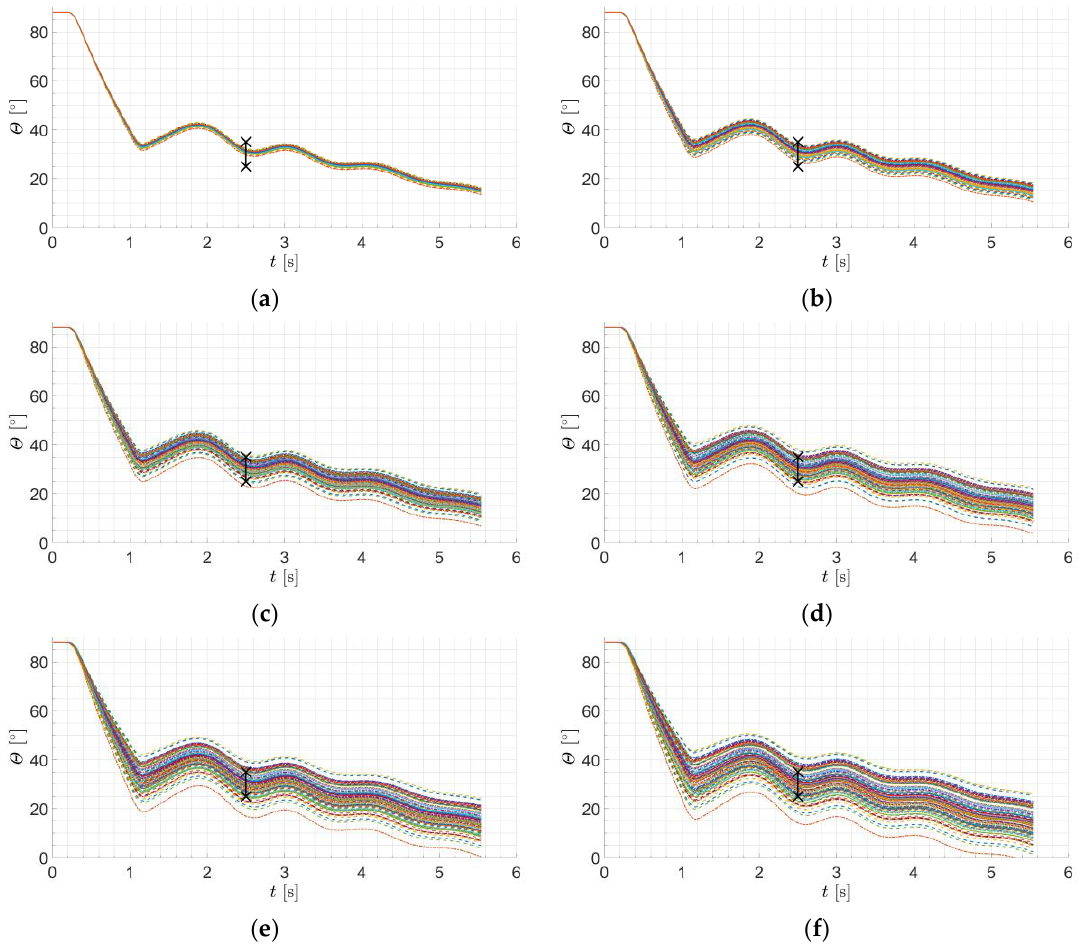
Figure 17. Projectile pitch angles for various 𝜏 1 , 𝜏 2 , 𝜏 3 standard deviations: ( a ) 0.001 s; ( b ) 0.0003 s; ( c ) 0.005 s; ( d ) 0.007 s; ( e ) 0.009 s; ( f ) 0.011 s.